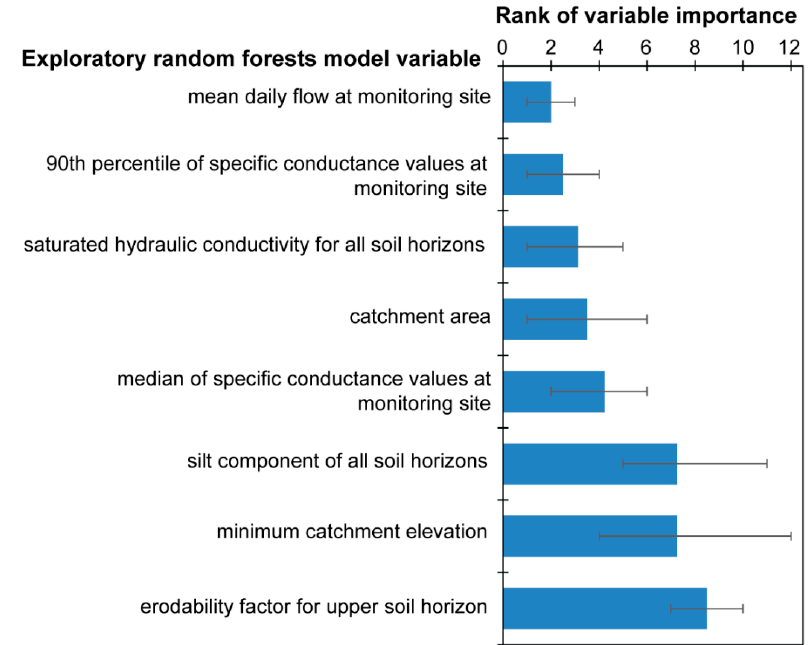
Figure 4. Average rank of decrease in exploratory model accuracy for the eight most important variables for eight random forests models that produced the optimized combined out-of-bag and N class error. Whiskers represent minimum and maximum ranks among the eight models.